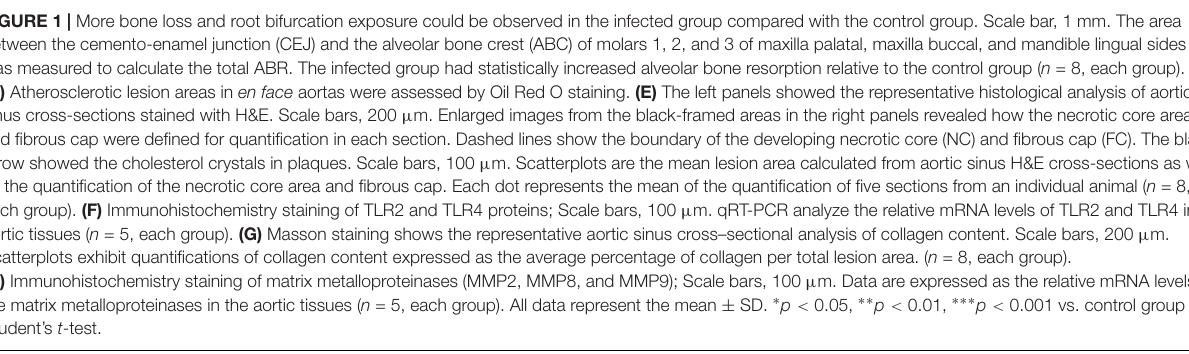
not show a statistically significant difference in expression ( Figure 2D ). Cholesterol acyltransferase 1 (ACAT-1), the gene that mediates cholesterol transformation in macrophages, was upregulated in the infected group ( p < 0.05) ( Figure 2D ).